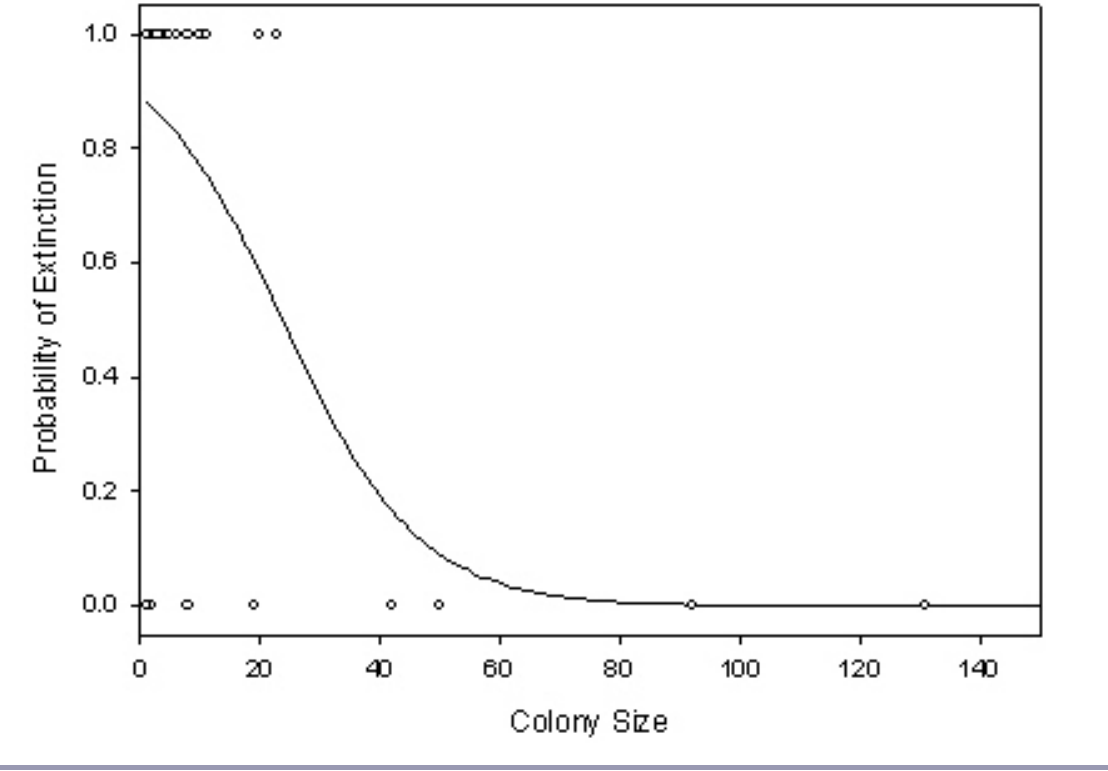
Fig. 3. Sizes and extinction rates of Ivory Gull colonies on Ellesmere Island and Devon Island in 2002– 2006. Circles represent actual observations; the curve is a fitted binomial